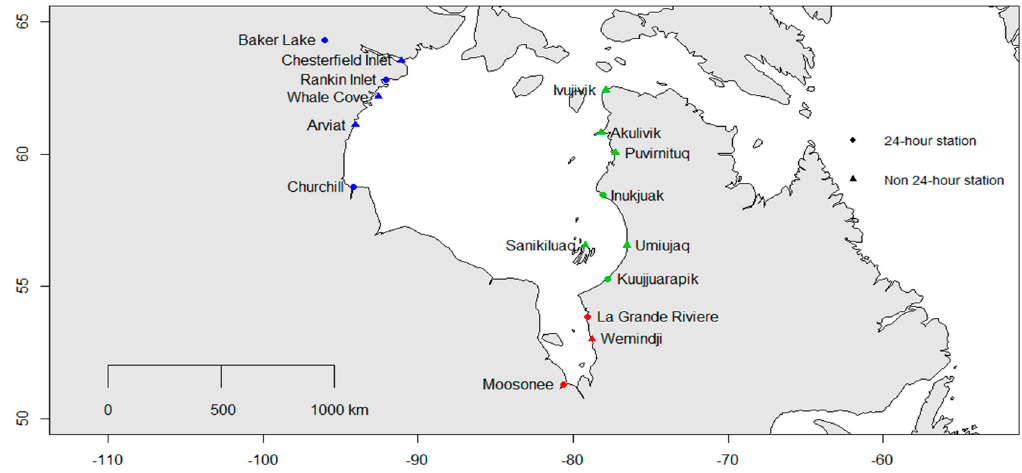
Figure 1. Location of airport sites used in this study. Diamond points indicate stations with 24 h observations and triangles for those stations that do not. Stations in Western Hudson Bay, Eastern Hudson Bay and James Bay are mapped in blue, green and red respectively based on their regional groupings.